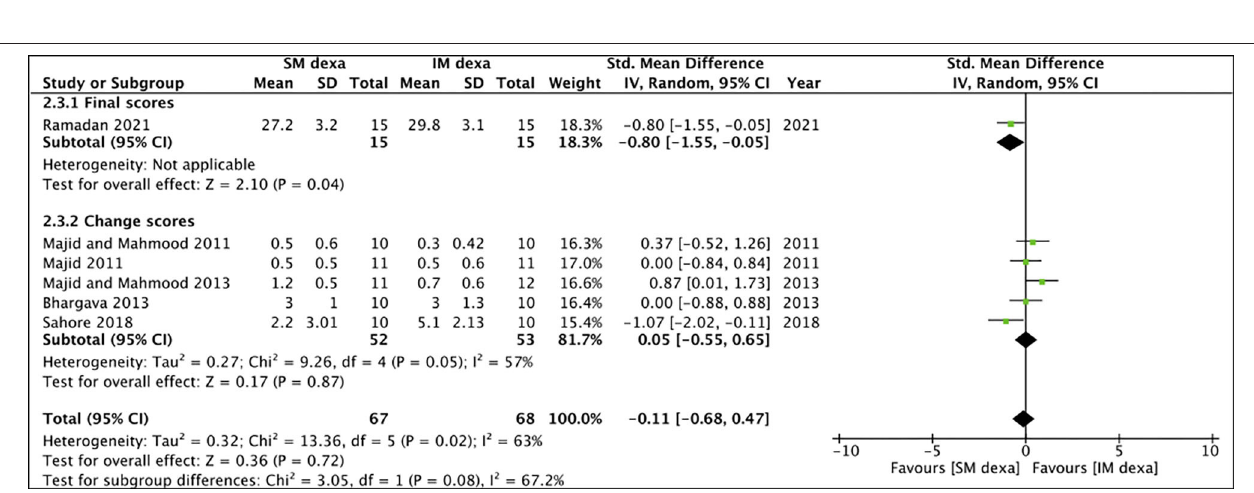
FIGURE 10 | Meta-analysis of early swelling between SM and IM dexamethasone (dexa) for third molar surgeries. Sub-group analysis performed based on final scores or change scores.